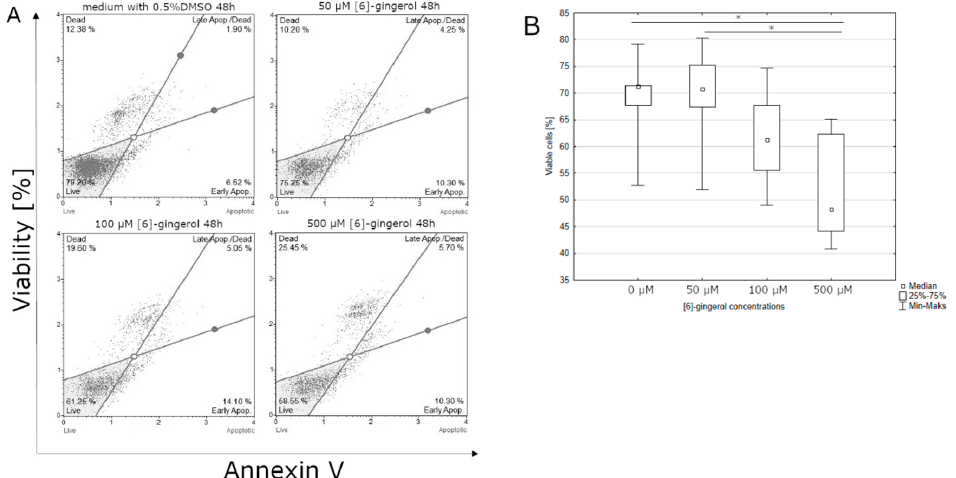
Figure 3. ( A ) [6]-gingerol induce apoptosis in the U-118MG cells. Cells were treated with DMSO or various concentration of [6]-gingerol for 48 h. Adherent cells were collected and stained with Annexin V and 7-AAD and events for live cells were counted with the Muse Cell Analyzer; ( B ) e ff ect of increasing [6]-gingerol concentration on U-118MG living cells percentages after 48 h incubation using Annexin V staining. The representative experiment is a median and a di ff erence between [6]-gingerol concentration and the control evaluated using ANOVA Friedman p = 0.029 and post-hoc tests * p < 0.05.